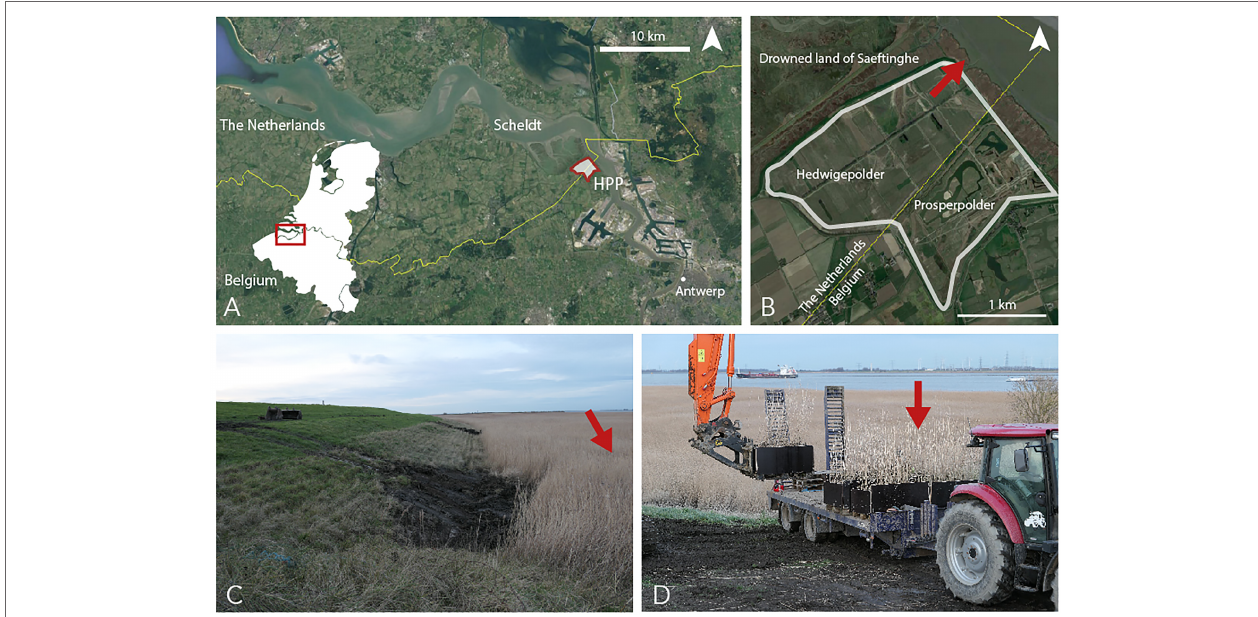
FIGURE 3 | Aerial picture showing the Scheldt estuary from the mouth to the city of Antwerp (A) . The monolith extraction took place within the marshes along the Hedwige- Prosperpolder (HPP) at the Dutch-Belgian border (yellow line) (B) within a mature, high marsh location adjacent to the dike (C, D) . Red arrows indicate the extraction location in the different figures.